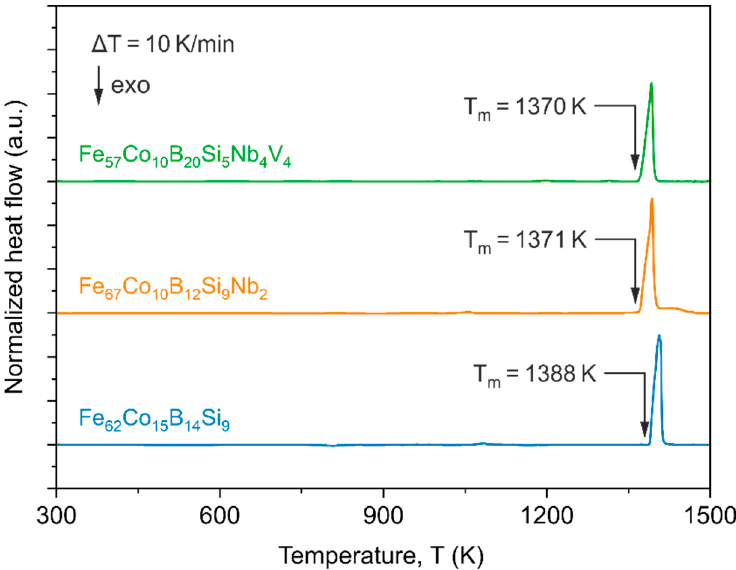
Figure 3. DSC curves for the Fe 62 Co 15 B 14 Si 9 , Fe 67 Co 10 B 12 Si 9 Nb 2 , and Fe 57 Co 10 B 20 Si 5 Nb 4 V 4 alloys.